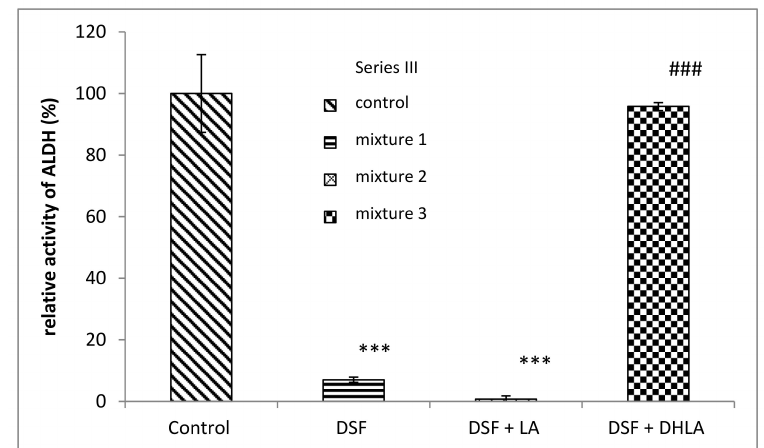
Figure 3. DHLA was able to protect ALDH against the inhibitory e ff ect of DSF. The ALDH activity was assayed with propionaldehyde (8 µ M) as a substrate by measuring the reduction of NAD (1 mM) at 340 nm. Data are presented as a percentage relative to the control (100%) (without DSF, LA, and DHLA). Three independent experiments were performed, each in triplicate. Data are shown as the mean ± SD. Significant vs. control sample: *** p < 0.001. Significant vs. DSF sample: ### p <